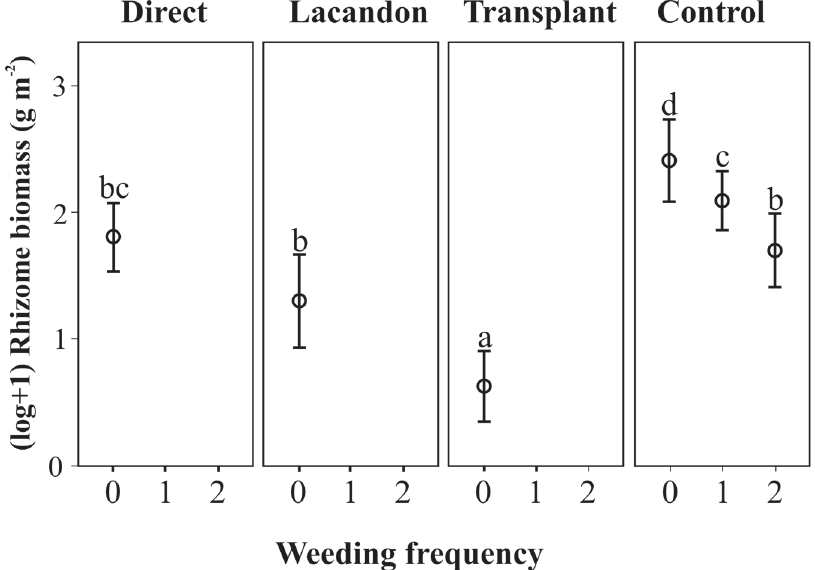
Figure 2. Bracken fern biomass (Log + 1) mean and 95% confidence intervals (g m − 2 )